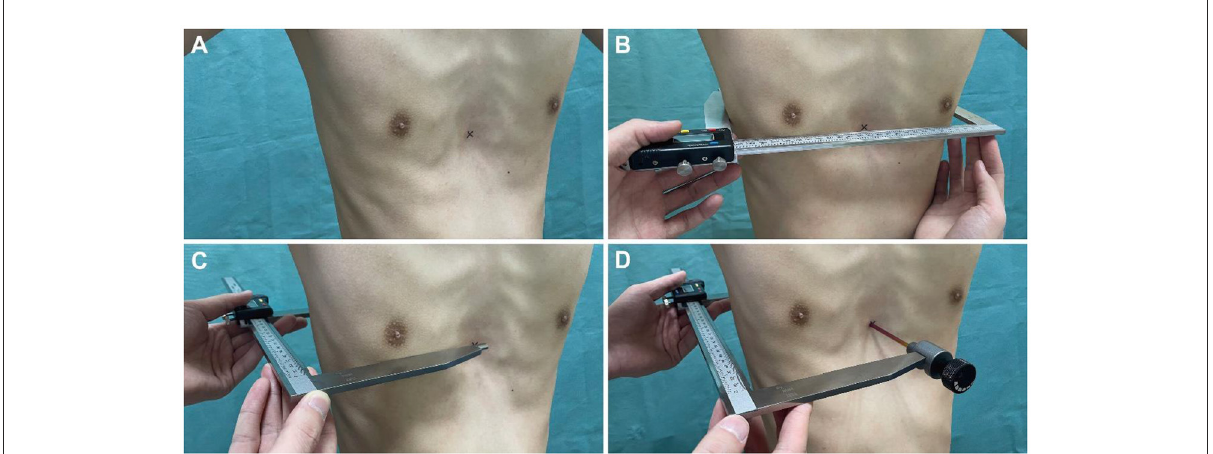
FIGURE2 Methods of caliper-based external measurement. (A) Marked the deepest point of anterior chest wall depression on the body surface with an erasable marker. (B) On horizontal plane of the deepest depression of anterior chest wall, measured the maximum distance between the parallel tangents of bilateral chest wall (a in Figure 1B). (C) Measured the maximum distance between the parallel tangents of anterior-posterior chest wall (c in Figure 1B). (D) Measured the minimum distance from the deepest point of anterior chest wall depression to the double tangent of bilateral posterior chest wall (b in Figure 1B).